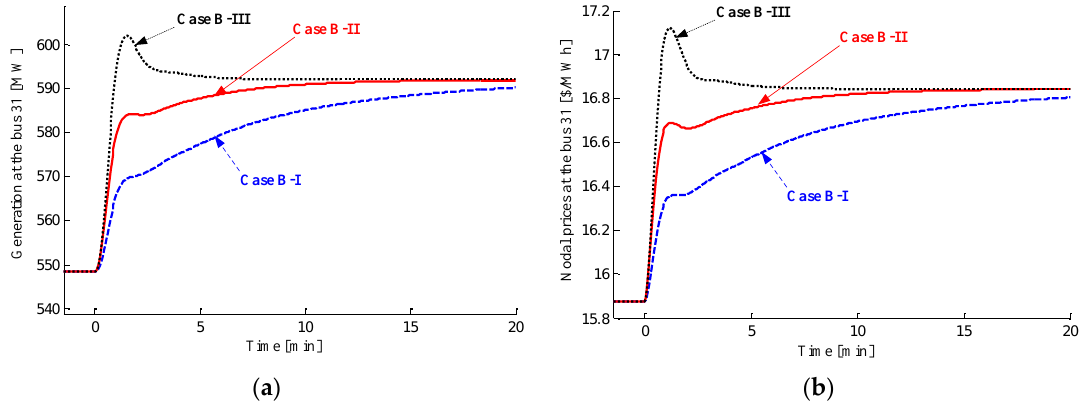
Figure 7. Simulation results for selected bus 31 in the line trip scenario using the framework: ( a ) amount of generation; and ( b ) nodal prices.